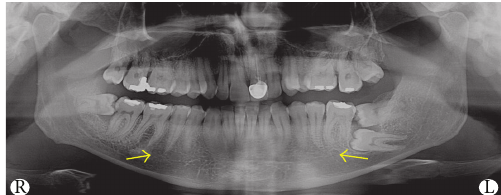
Figure 1: 20-year-old patient’s panoramic radiograph in which the images of the right MF and the end of the left mandibular canal are pointed by the arrows.